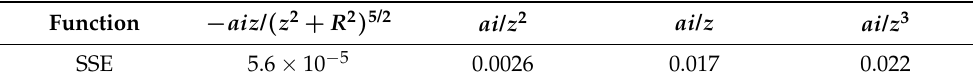
Table 2. The results of data analysis using sum of squared errors.